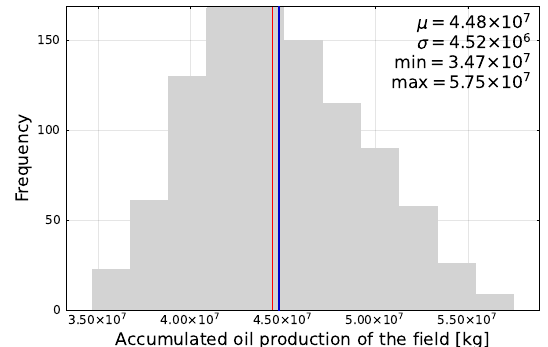
Figure 4: Prior model uncertainty. Red line is the ac- tual